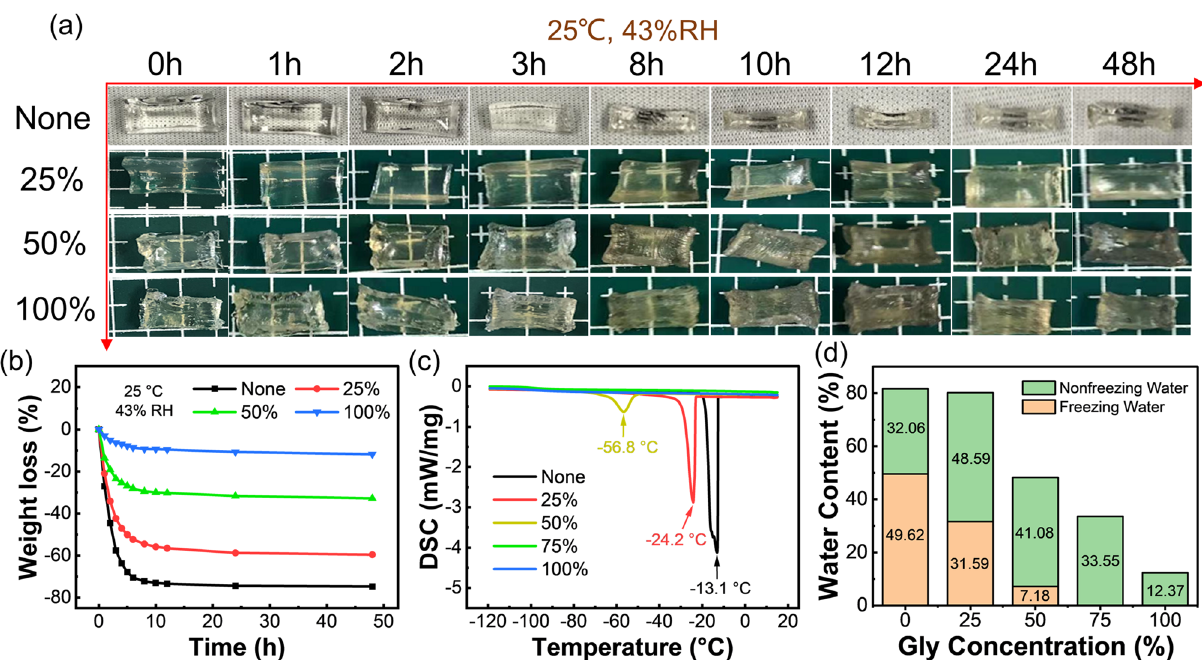
Fig. 2 a Photographs of the morphology evolutions of the PAM/Carrageenan DN hydrogels that were not soaked and soaked in 25, 50, and 100% glycerol solutions, respectively, after being stored in a dry environment of 25 °C and 43% RH for 48 h. b Time evolution of the weight loss percentage of the hydrogels in a when stored at 25 °C and 43%RH. c DSC curves of hydrogels that were not soaked in glycerol and soaked in 25, 50, 75, and 100% glycerol solutions, respectively. d Contents of freezing and nonfreezing water in hydrogels soaked in glycerol solutions with different